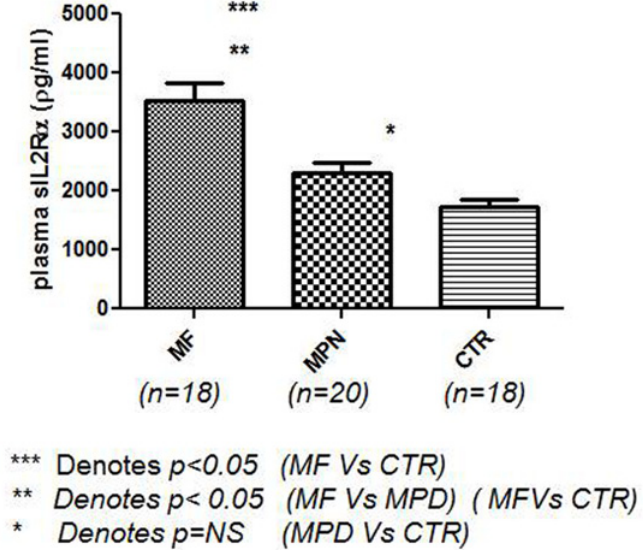
Fig 3. Plasma sIL-2R α levels in Patients with MF and others. Levels of sIL2R α in peripheral plasma were quantified using BD OptEIA ELISA set for human sIL-2R α . MF patients had a significantly elevated sIL-2R α compared with other MPN patients and controls. Other MPN patients were not significantly different from controls. MF = myelofibrosis, MPN = myeloproliferative neoplasm, CTR = control. *** P < 0.0001, ** P < 0.0001, NS = no